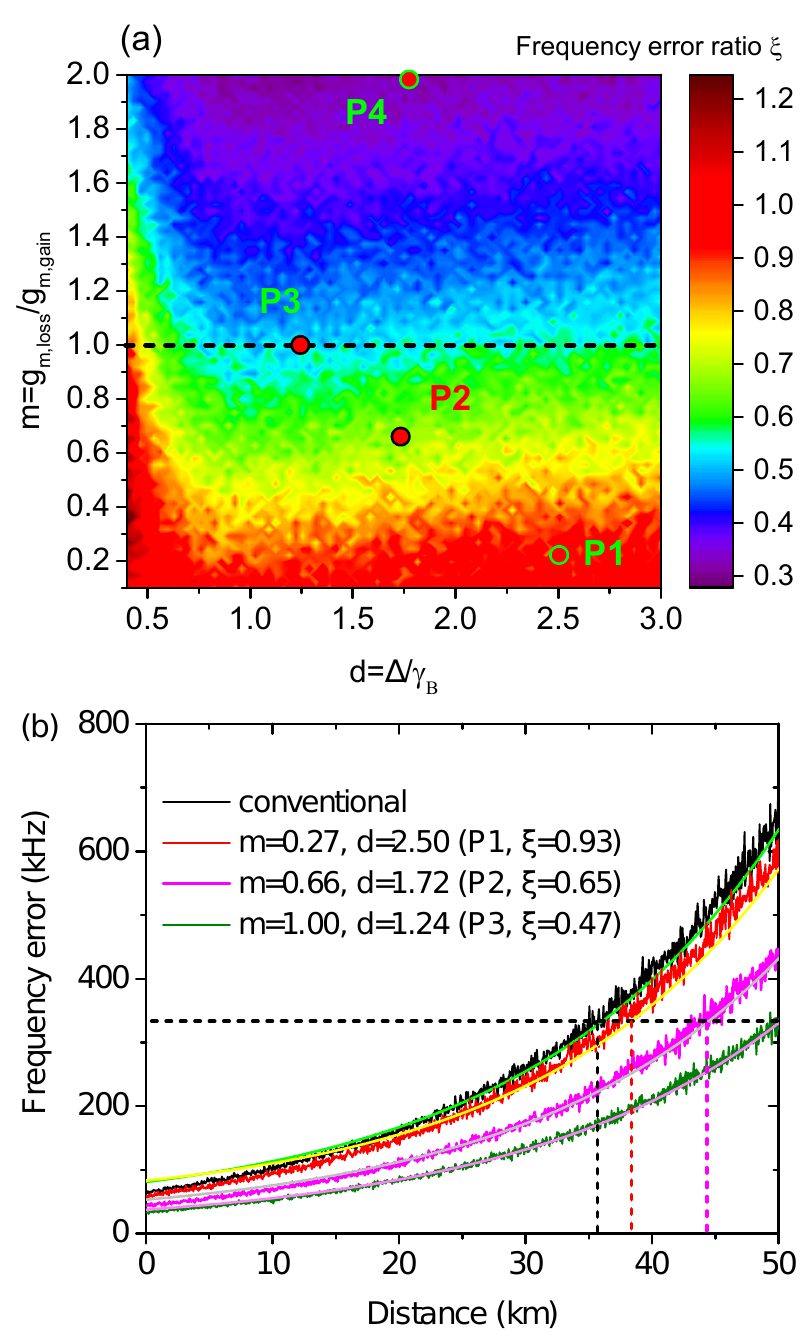
Figure 3. Simulation results of: ( a ) the frequency error ratio ξ as a function of m and d ; ( b ) the distribution of the BFS determination error with the conventional and engineered BGS with selected m and d values in ( a ) marked as P 1– P